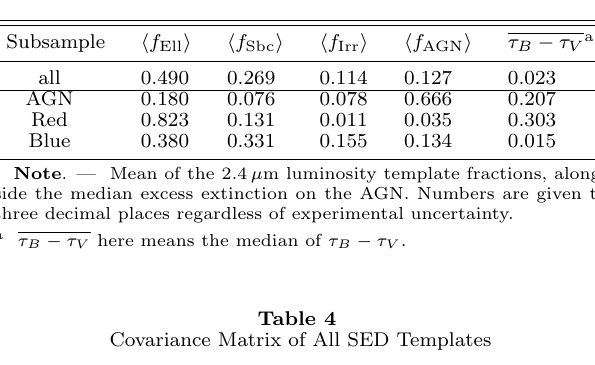
Figure 4. Panel a shows the SED standard deviation ( (cid:112) Σ( ν,ν )) for all galaxies in the sample, and Panels b , c , and d show the same data for AGN, red, and blue galaxies, respectively. The vertical dashed line highlights the effective wavelength of the normalization luminosity, and the dotted lines show the effective rest frame wavelength of WISE ’s W1 channel for galaxies at the redshifts z = 0 and 1. Note the there are no units given for Σ( ν,ν (cid:48) ) because the normalization luminosity used, L N , fits the standard practice in astronomy of it’s weighting function, w N ( ν ), having the units needed to make L N a weighted mean of L ν , that is w N ( ν ) has units [Hz − 1 ]. Table 5 Table 3 Covariance Matrix of AGN SED Templates Mean SED Parameters